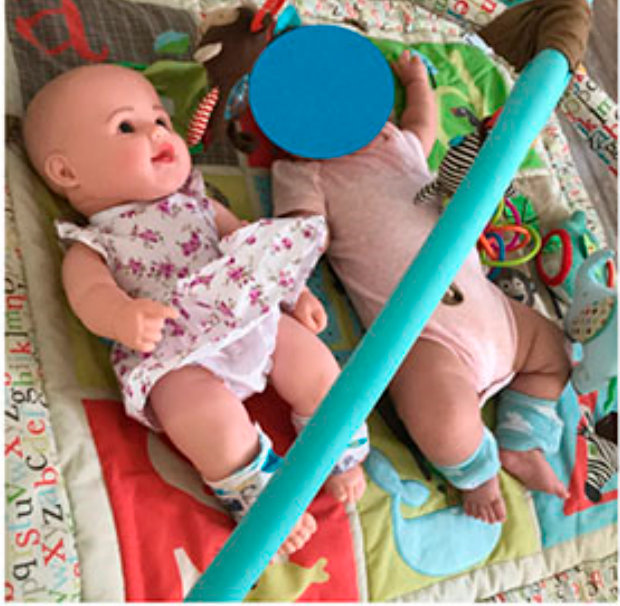
Figure 1. Infant and doll, both wearing sensors on each ankle.